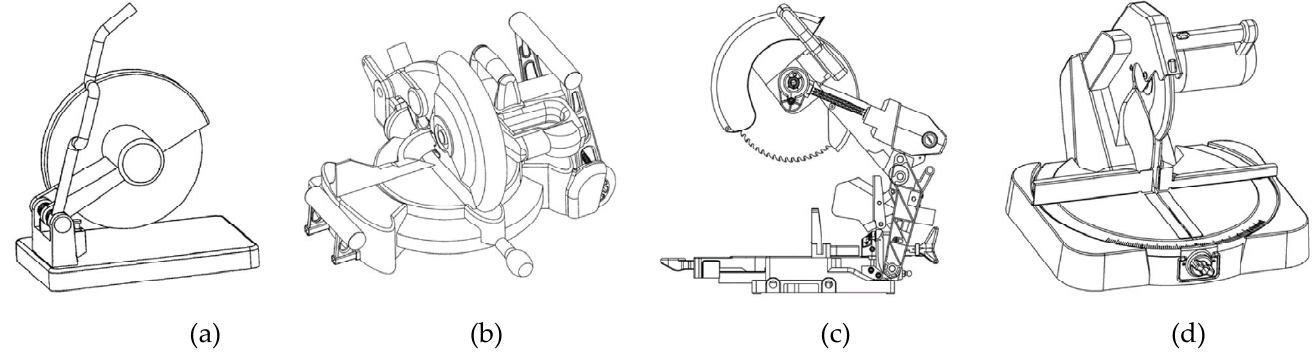
Figure 9. Product update: ( a ) First generation; ( b ) second generation; ( c ) third generation; ( d ) fourth generation.